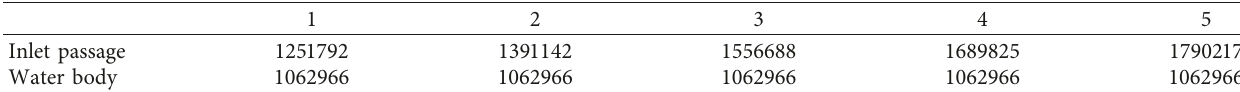
Figure 4: Grid and Y + contour of the inlet passage domain. (a) Surface mesh of inlet passage outlet. (b) Inlet passage. (c) Y + contour. Table 2: Grid